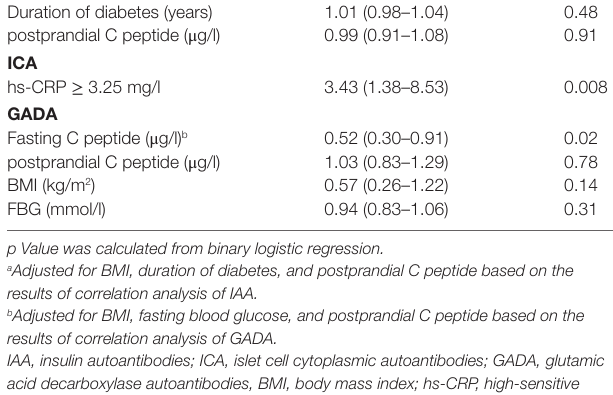
Asian participants than that in white European participants